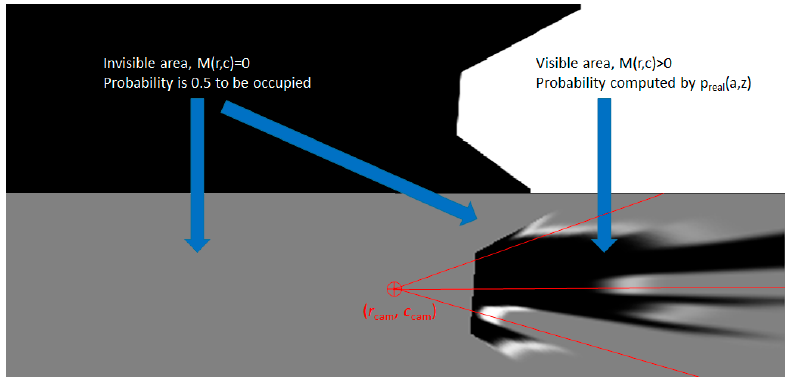
Figure 7. Computing the measurement occupancy probability values for all the grid cells. The cells that are not observable ( M (r,c) = 0) have a default 0.5 value of the probability, while the other have the probability decided by the rays cast from the camera point that meet obstacle areas.